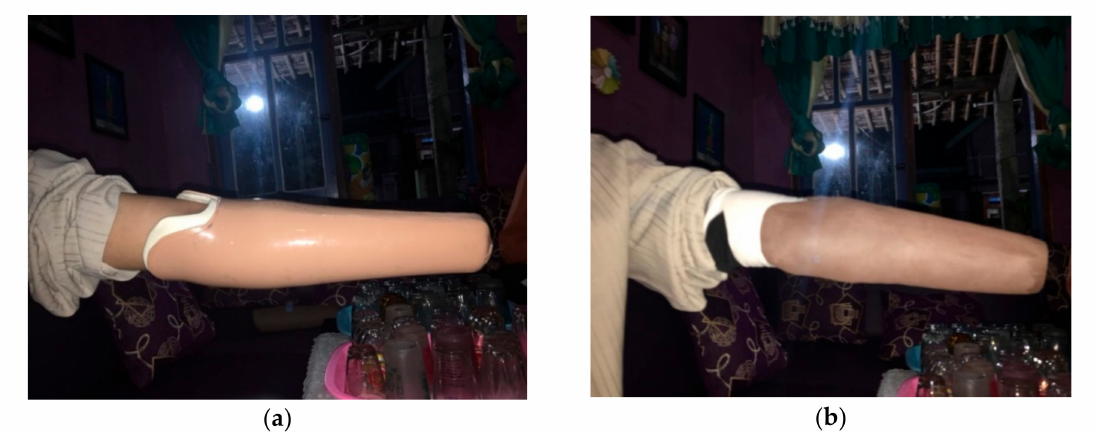
Figure 10. ( a ) Resulted casting socket and ( b ) photogrammetry-3D printing method socket.